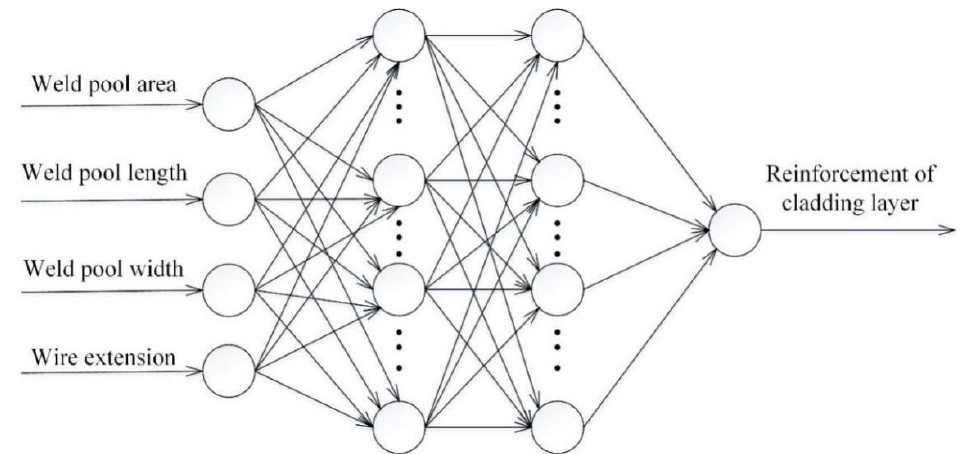
Figure 8. Structure of prediction model.